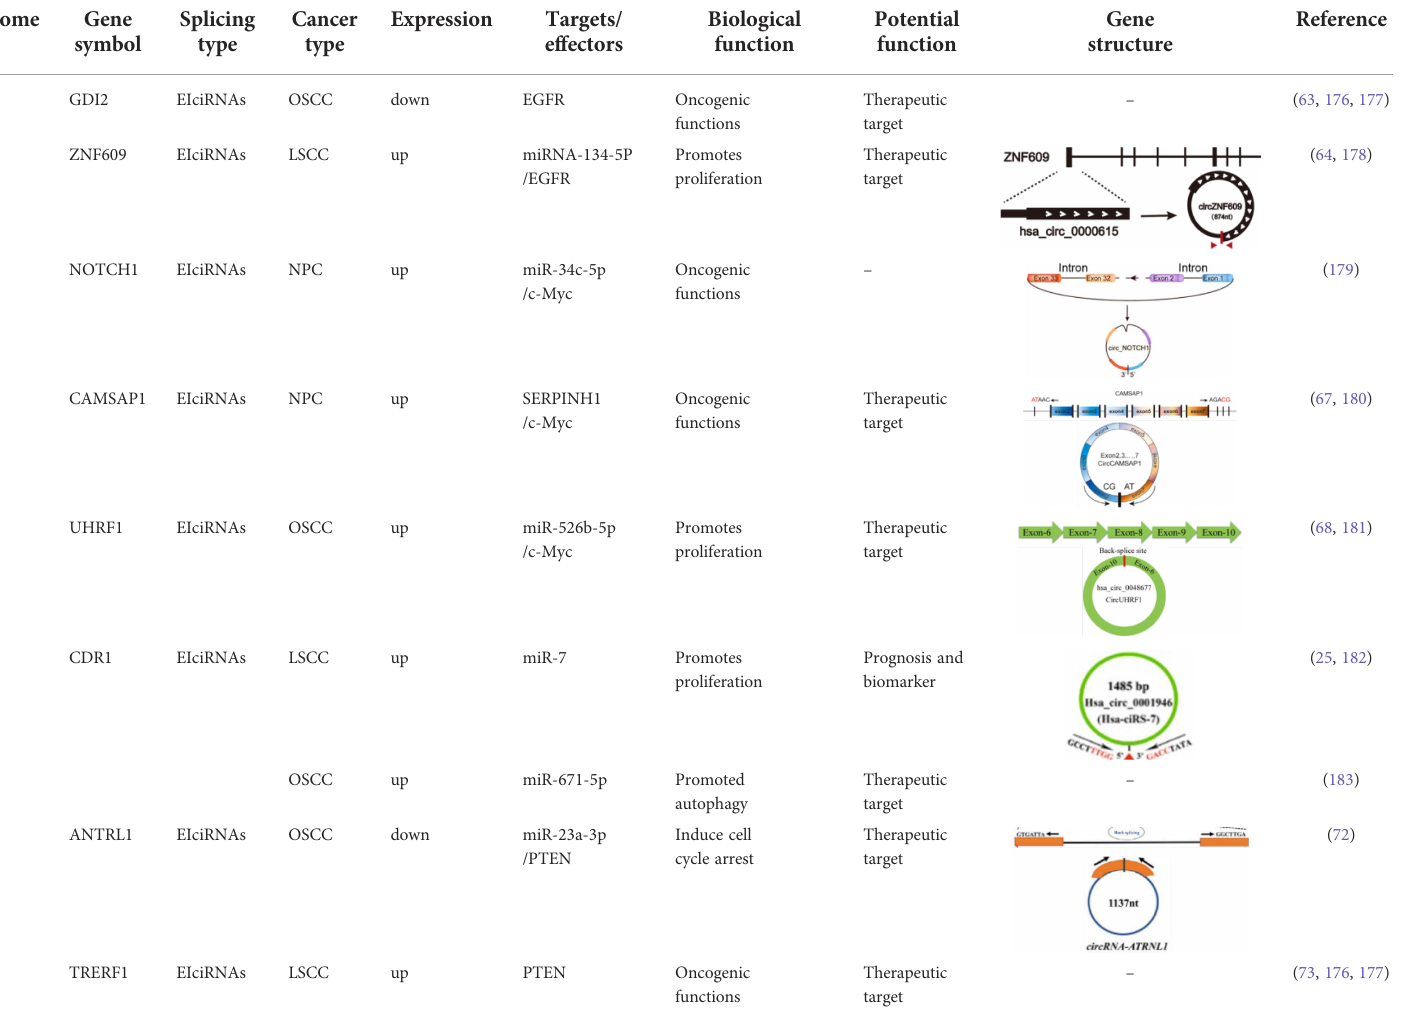
TABLE 1 Mechanisms of action and biological functions of key circRNAs involved in